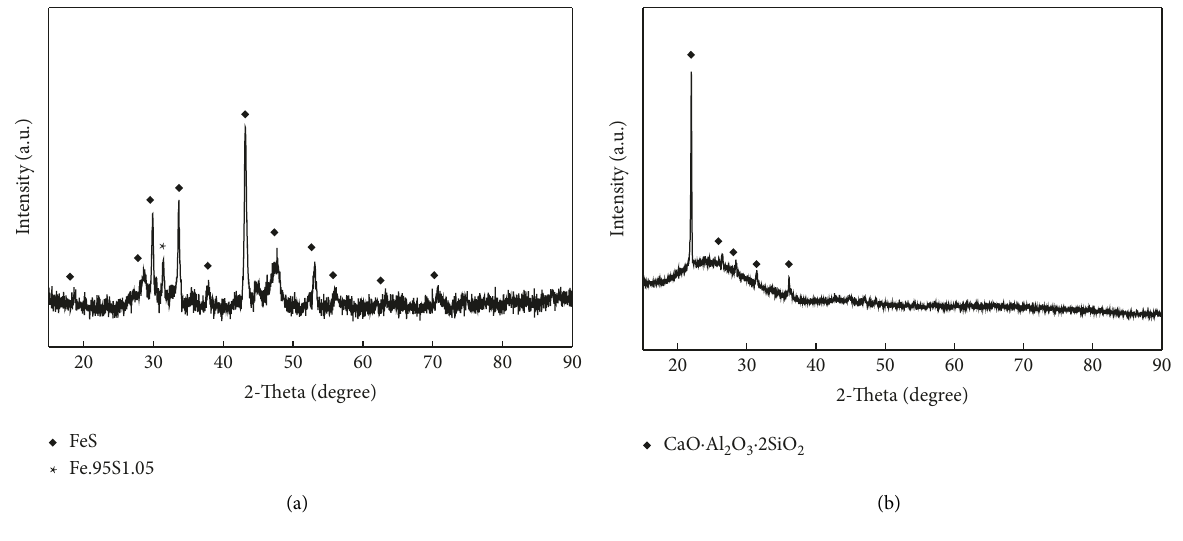
Figure 5: XRD pattern of iron matte and smelting